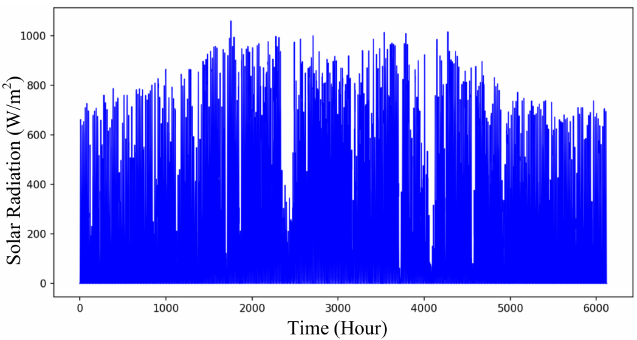
Figure 8. The solar radiation dataset for Tainan (Taiwan) in